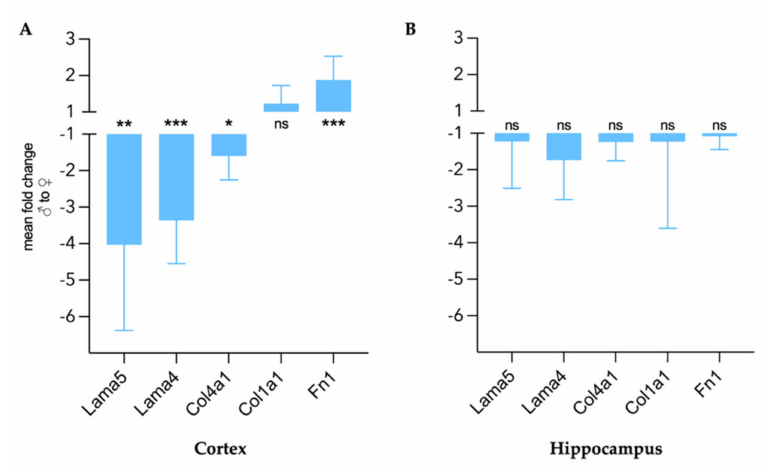
Figure 3. Sex differences in gene expression of ECM components in healthy cerebral cortex ( A ) and hippocampus ( B ) expressed as mean fold change of male gene expression compared to female with 95% CI. n female = 6, n male = 6. Group comparison performed with unpaired t test with Welch correction. Lama5 = laminin α 5, Lama4 = laminin α 4, Col4a1 = collagen type IV α , Col1a1 = collagen type I α 1, Fn1 = fibronectin 1. * p < 0.05, ** p < 0.01, *** p < 0.001, ns = not